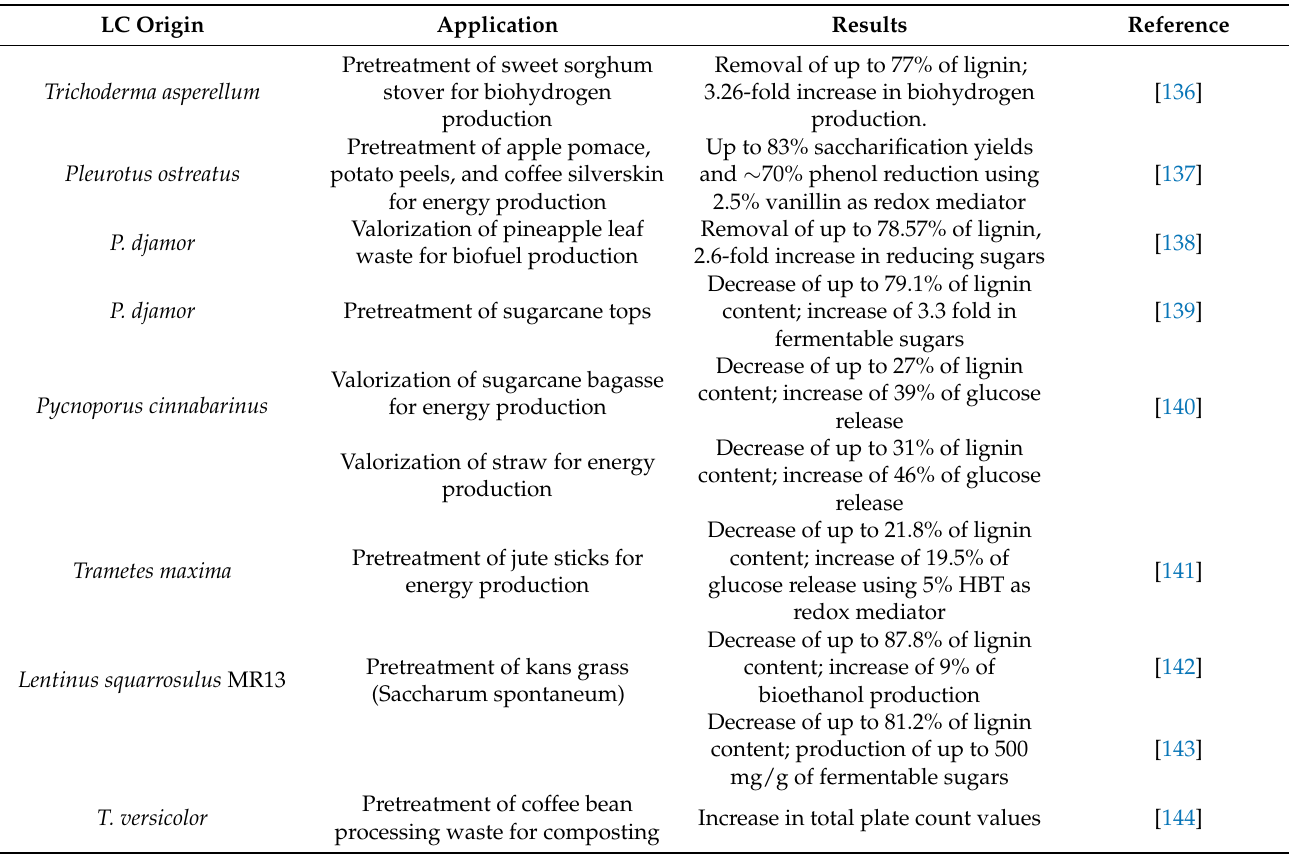
Table 3. Laccase application for the valorization of